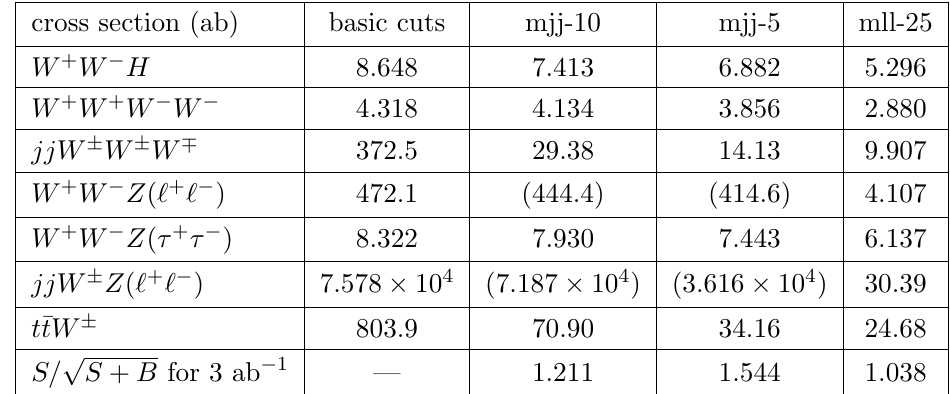
Table 1 . Cut (cid:13)ow of the signal and background cross sections and the signi(cid:12)cances at the 13-TeV LHC. The b -tagging e(cid:14)ciency is assumed to be